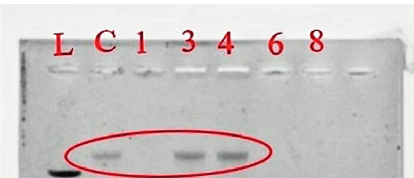
Figure 5: DNA cleavage analysis on 0.8% agarose gel. Lane L, 1kb ladder; C, control DNA; 1, complex 2 ; 3, BUT; 4, DPA; 6, complex 4 ; 8, complex 3 . The gel indicates that all the complexes had DNA nuclease activity while the ligands did not cleave nor nuclease the